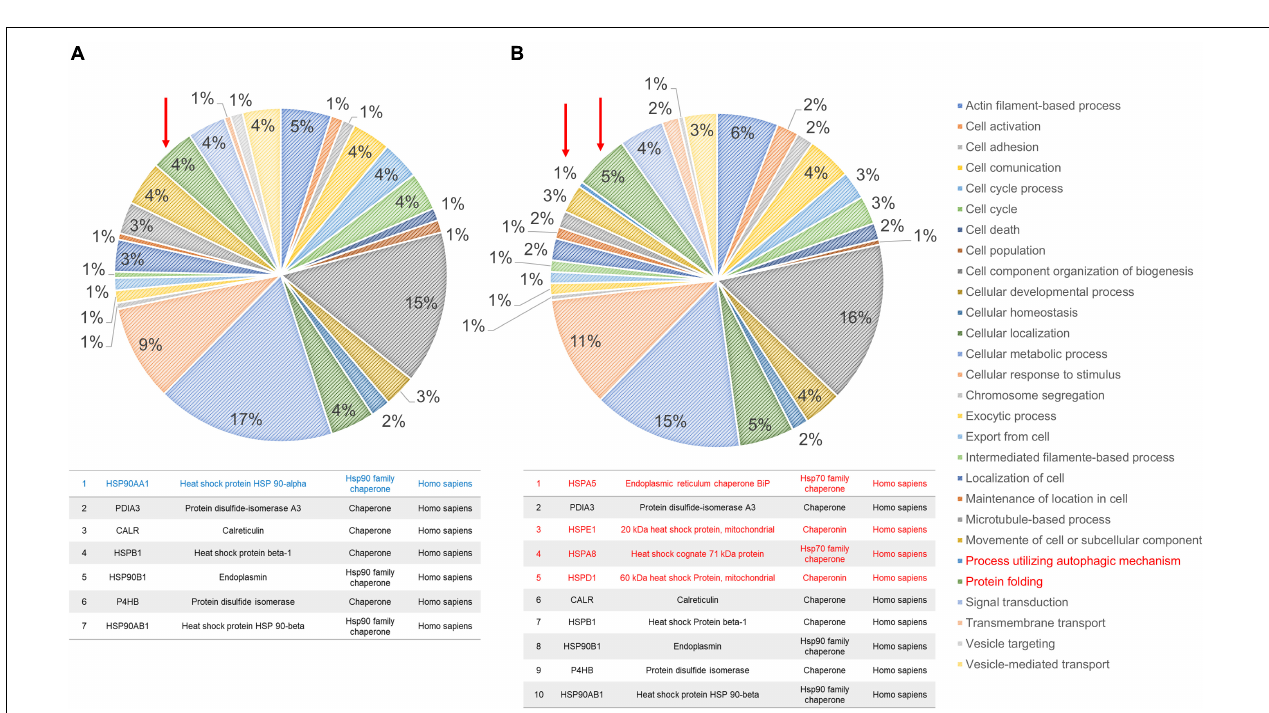
FIGURE 7 | Ontological subclassification of cellular processes of the proteins identified in fibroblasts derived from patients (AD1 and AD2) and controls (NA2 and NA3). From the ontological classification of molecular function, the subclassification of cellular processes (accounting for ∼ 30% of the proteins identified by mass spectrometry) was selected. (A) Distribution of proteins from fibroblasts of the control individuals according to the cellular process in which they are involved. (B) Distribution of proteins from fibroblasts of the FAD individuals according to the cellular process in which they are involved. In both panels, values are expressed as percentage of the number of the proteins identified in the molecular classification. The arrow and the box in red indicate the classification of protein folding. As shown in Supplementary Tables 2,3 , control individuals (NA2 and NA3) have lower numbers of protein folding-associated cellular stress response proteins.